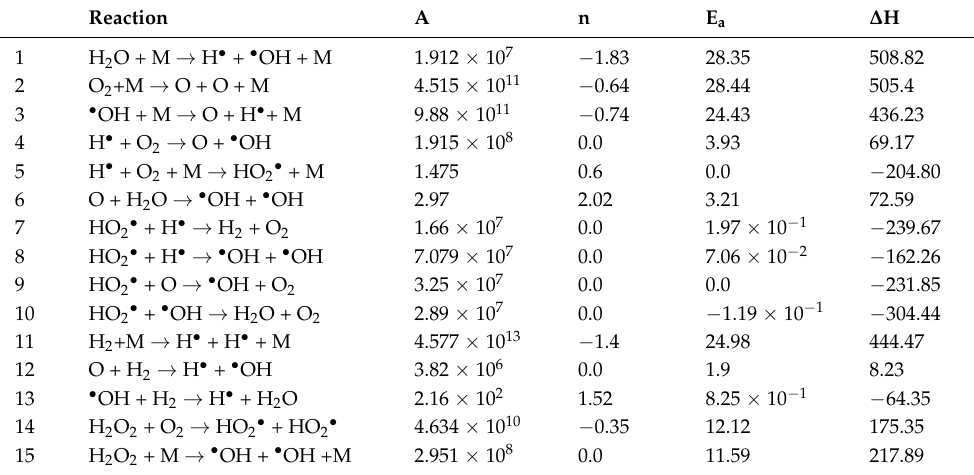
Table 2. Scheme of the possible chemical reactions inside a collapsing Argon bubble [32,33]. M is the third Body. A is in (m 3 mol − 1 s − 1 ) for two-body reaction [(m 6 mol − 2 s − 1 ) for a three-body reaction], and E a is in (KJ mol − 1 ) and ∆ H in (KJ mol − 1